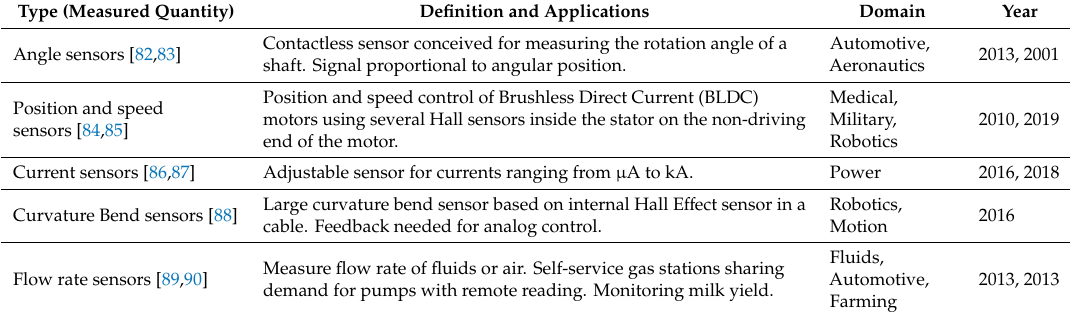
Table 1. Summary table of the main known macro devices with integrated Hall E ff ect. Classification is per measured quantity / physical